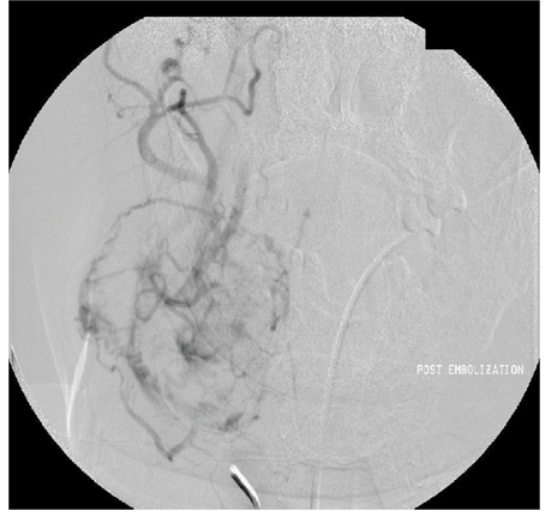
Figure 2. Post-embolisation with reduction in vascularity.